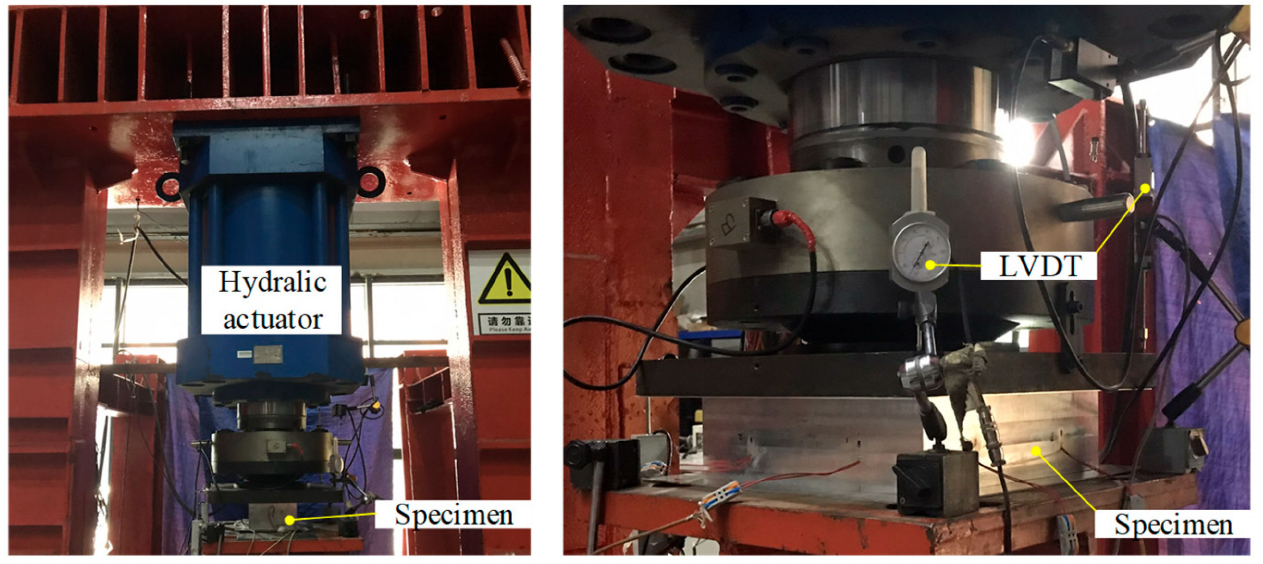
Figure 7. Testing